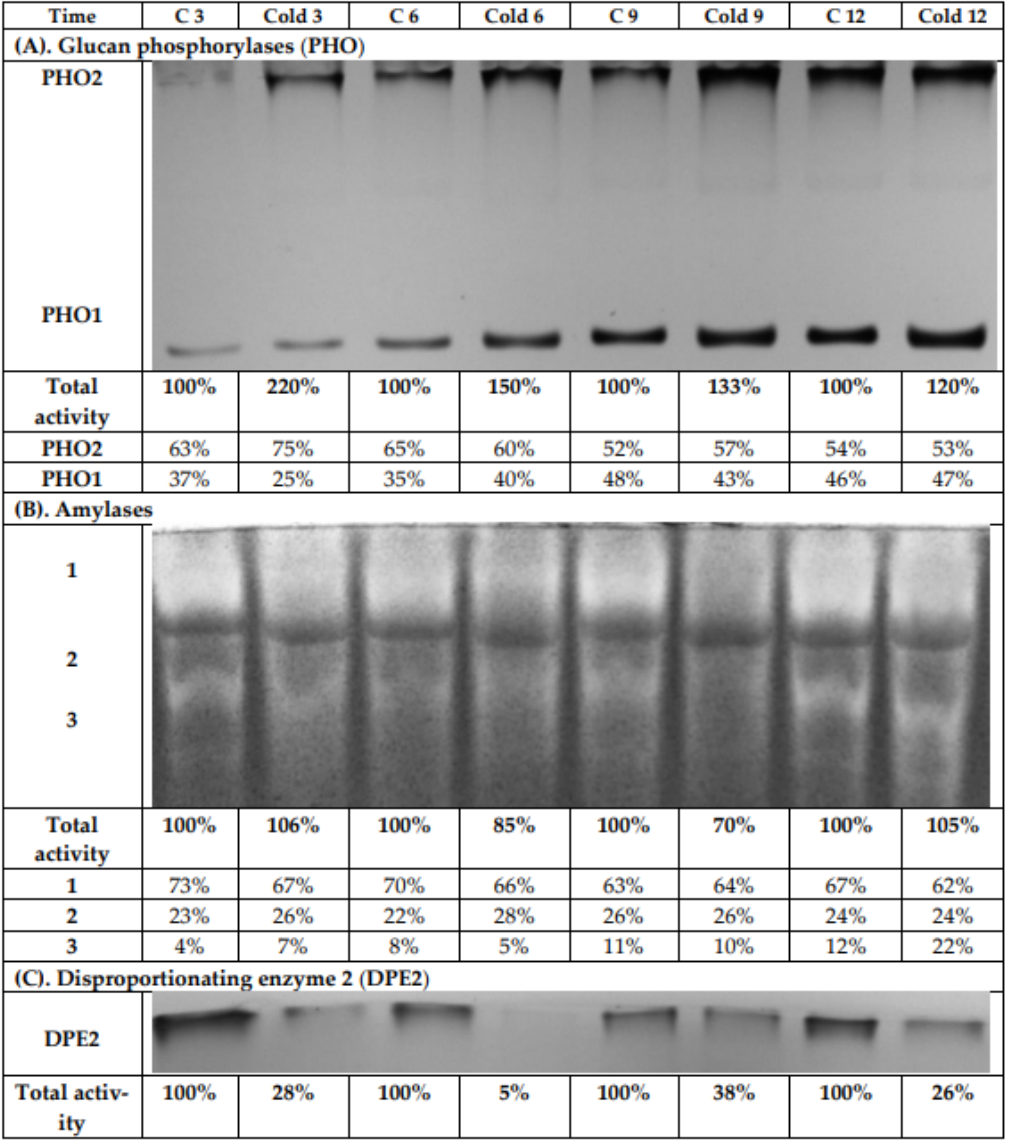
Figure 8. Activity staining of glucan phosphorylases ( A ), amylases ( B ), and disproportioning enzyme 2 ( C ) from leaves of potato growing under optimum conditions or lower temperature (2 °C) after native PAGE. Each lane was loaded with 100 μ g of proteins extracted from the leaves of both control and cold-stressed plants after 3, 6, 9, and 12 h. The intensity of the obtained activity bands was quantified by scanning the photos using the software GelQuant.Net 1.8.0 (www.biochemlab- solutions.com, accessed on 3 July 2021). The results were typical of at least four independent experiments. To verify the localization of the observed amylase activities, chloroplasts were iso- lated. All detected amylases were localized in the plastids, as they were also found in the